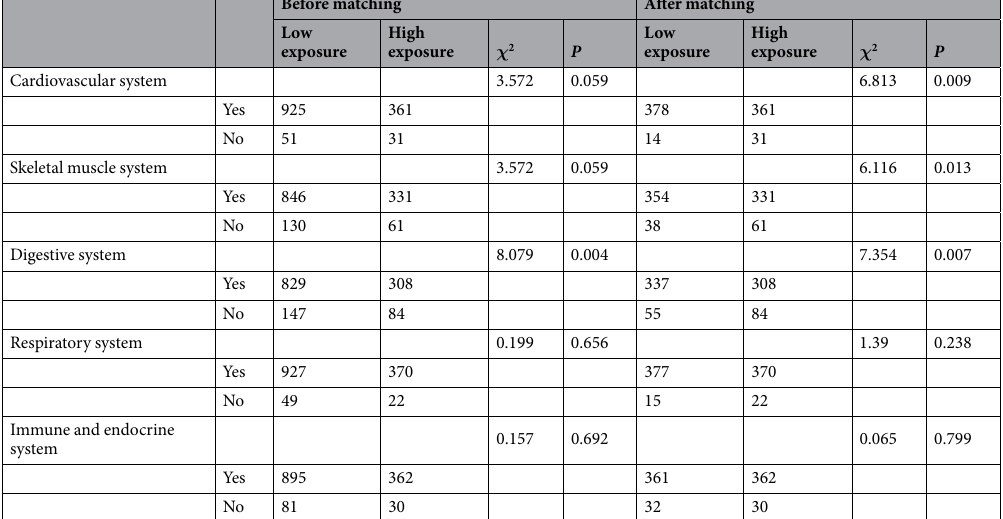
Before matching